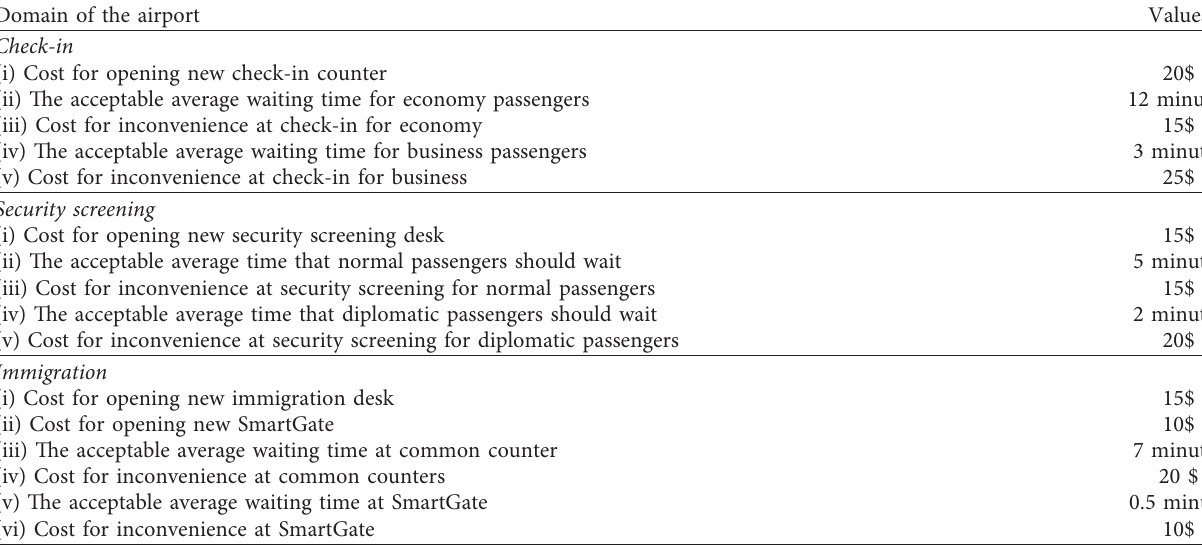
Figure 2: Snapshot of simulated annealing results. Table 1: Summary of the input data.